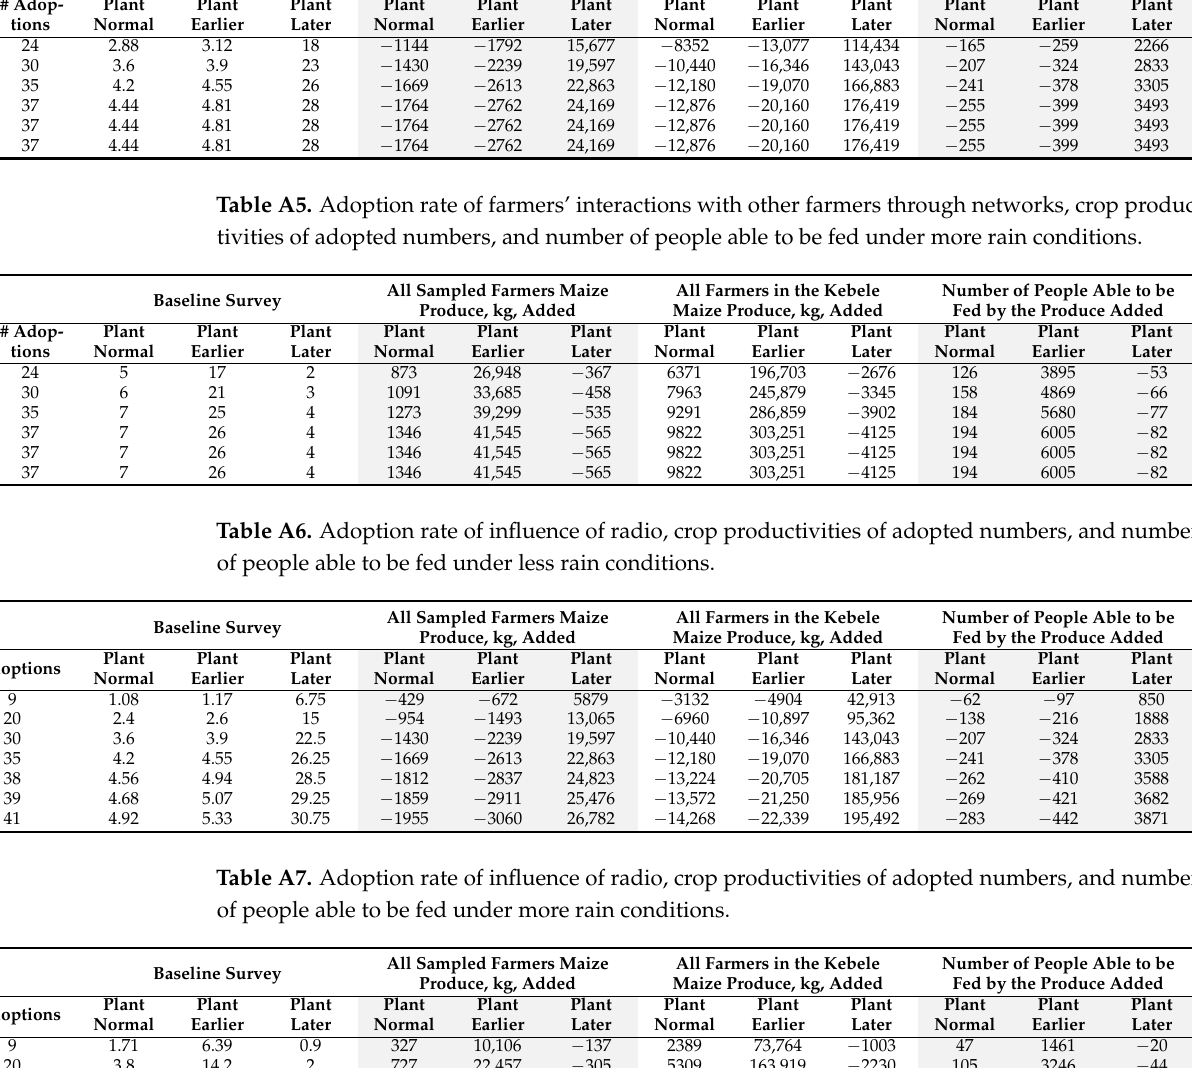
Table A4. Adoption rate of farmers’ interactions with other farmers through networks, crop produc- tivities of adopted numbers, and number of people able to be fed under less rain conditions. Baseline Survey